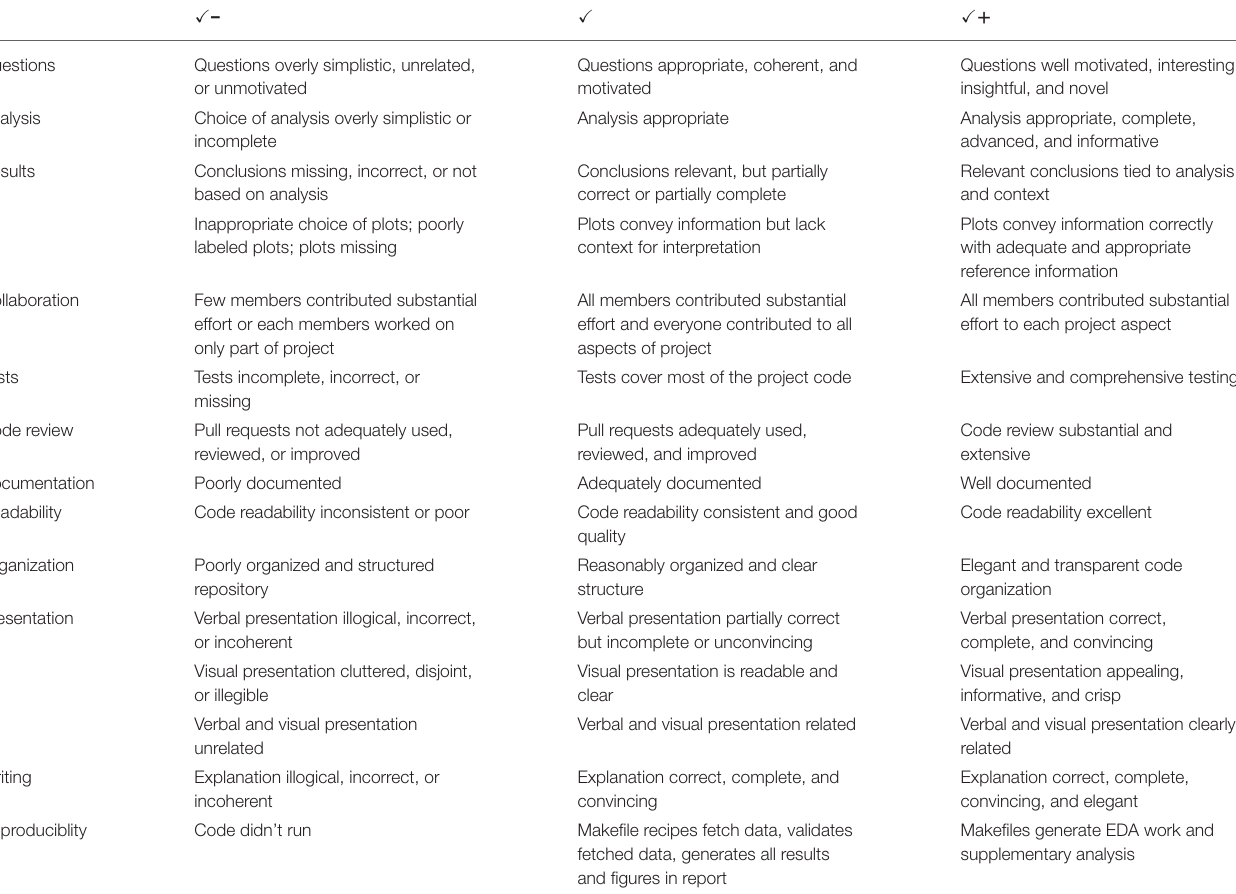
TABLE 1 | Project grading